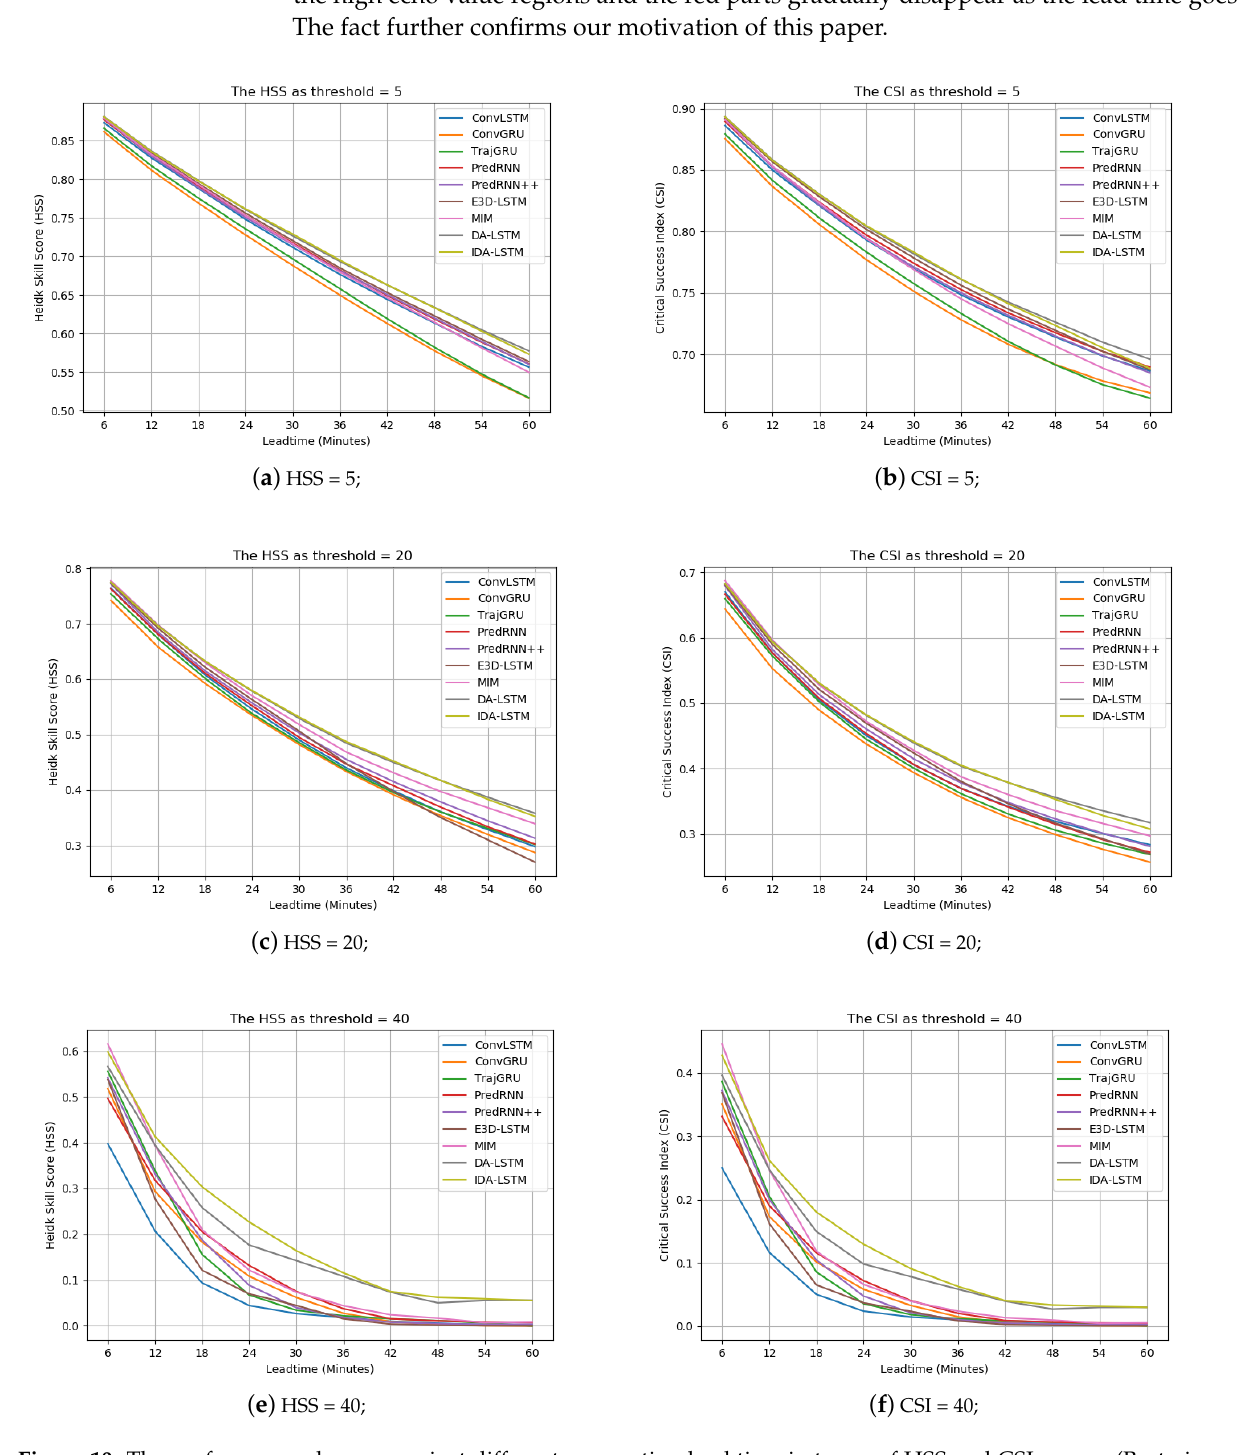
Figure 10. The performance changes against different nowcasting lead time in terms of HSS and CSI scores. (Best view in